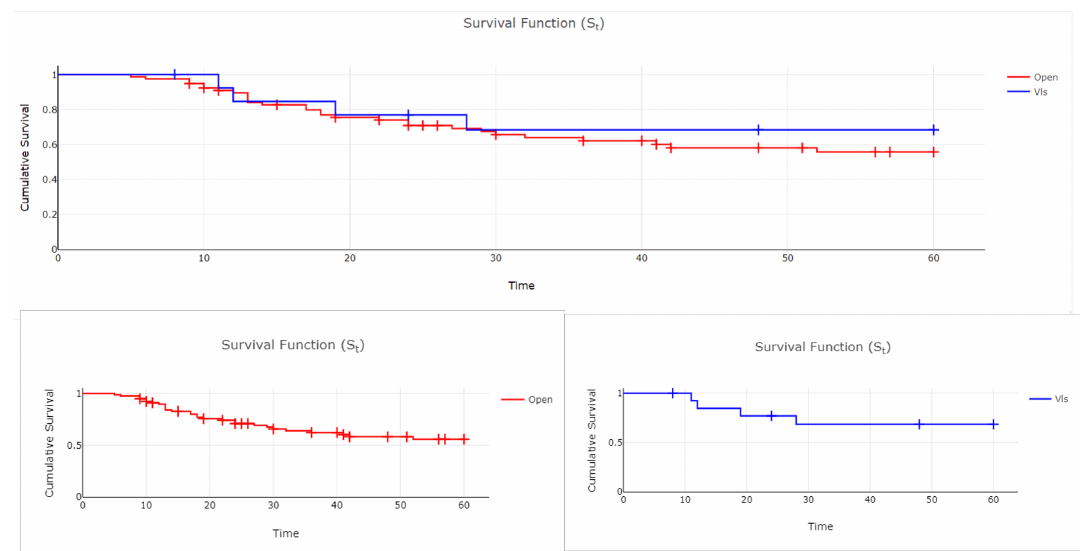
Figure 1. Kaplan-Meier overall survival curve according to surgical technique p = 0.490 (log rank test) (Color version of figure is available online).